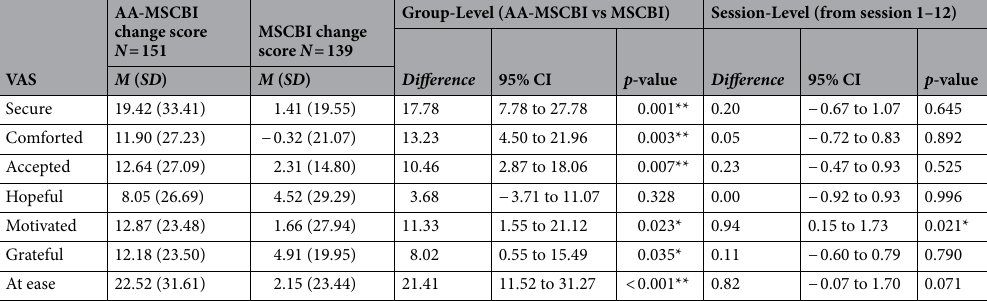
Table 3. Change in patients’ emotional states from pre- to post-sessions within-groups, between-groups and over time (session 1–12) for the animal-assisted psychotherapeutic mindfulness- and self-compassion-based group intervention (AA-MSCBI) and the standard psychotherapeutic mindfulness- and self-compassion-based group intervention (MSCBI). VAS Visual Analogue Scale, N number of change scores, M mean, SD standard deviation, 95% CI 95% confidence interval, Difference : coefficient estimating the mean difference as effect size, * p < 0.05, ** p < 0.01. A positive change score indicates an increase in the mentioned emotional state from pre- to post-session, a negative change score indicates a reduction in the mentioned emotional state from pre- to